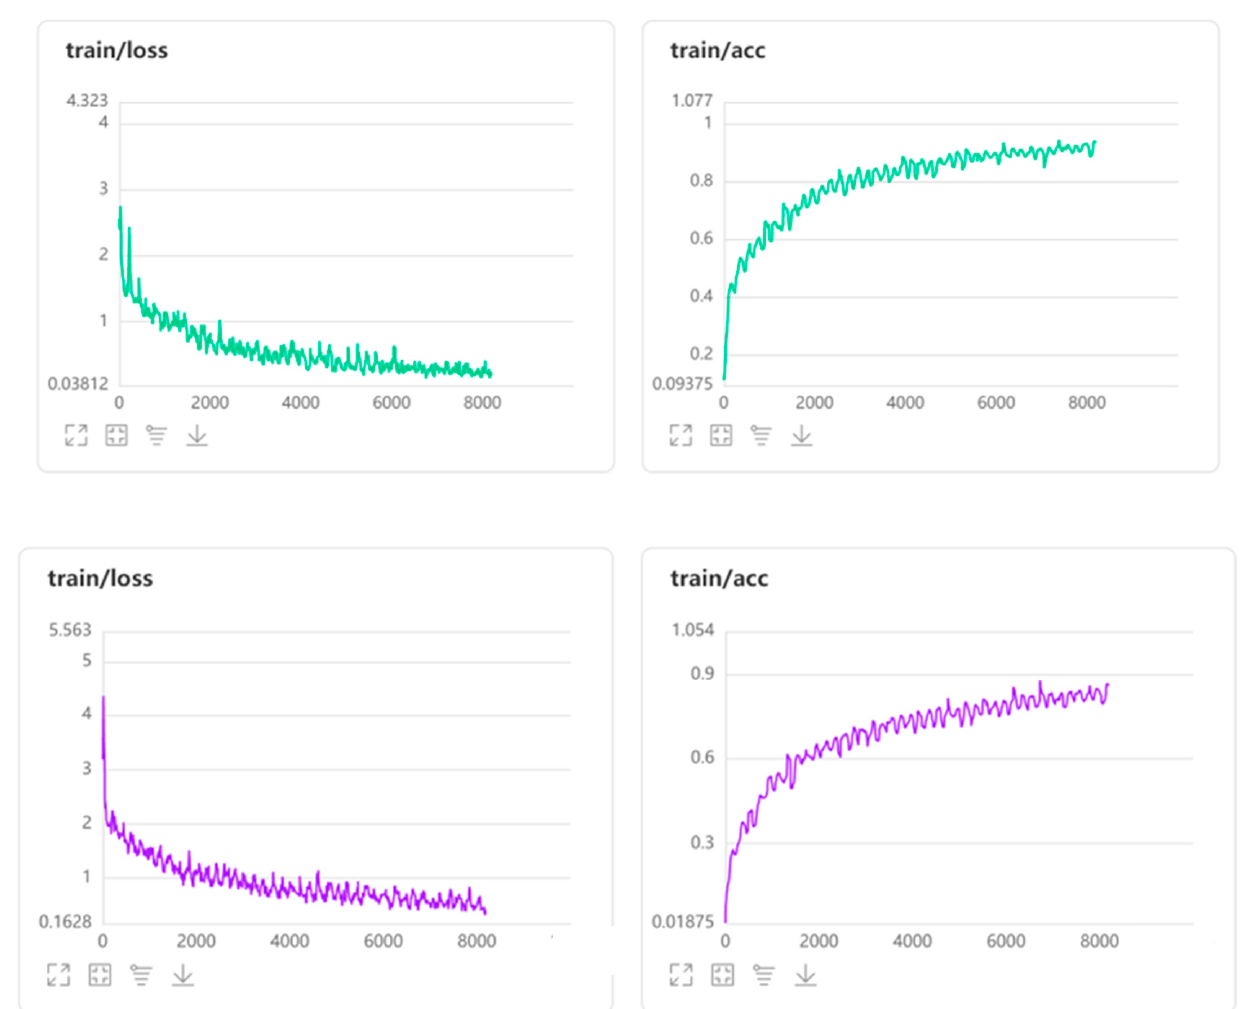
Figure 5. Training phase losses for summer and winter season.